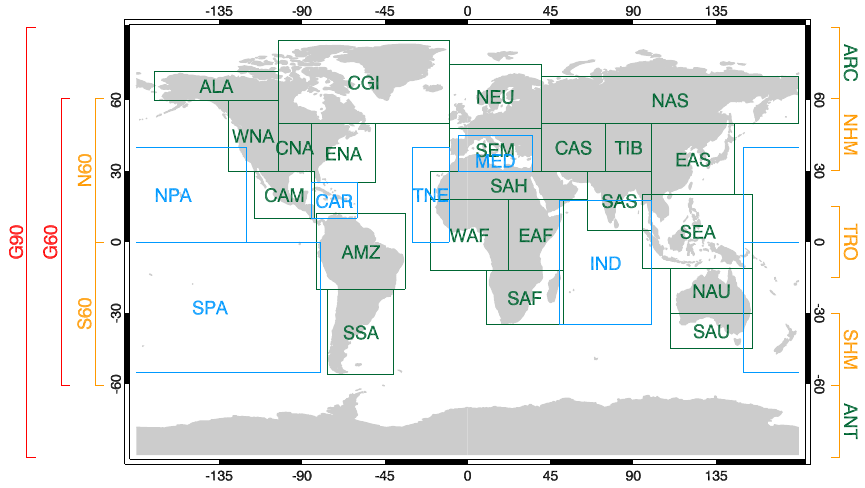
Fig. 3. Large-scale regions over land (green) and oceans (blue) based on the IPPC (2007) definition, complemented by global-scale zonal bands (marked at both sides in orange and red) typical for RO climate studies. The acronyms used for all regions are as well indicated. For details see Table